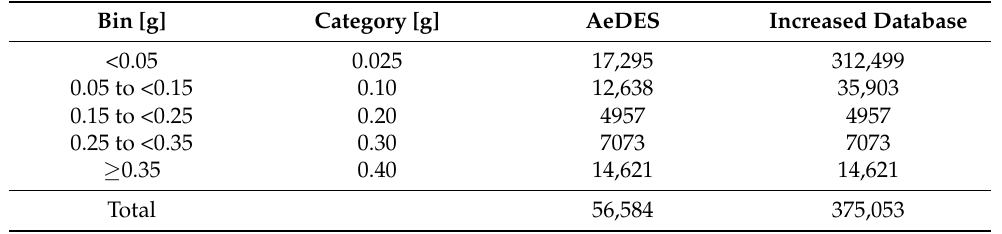
Table 1. Peak ground acceleration ( PGA ) bins, categorical values, number of buildings in AeDES database, and increased (AeDES complemented with census)